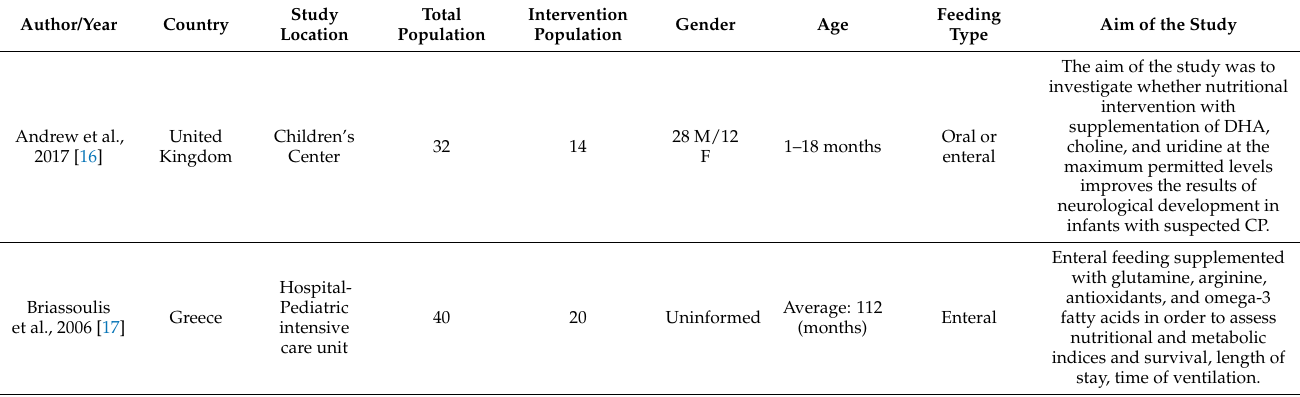
Table 1. Characteristics of the studies included .